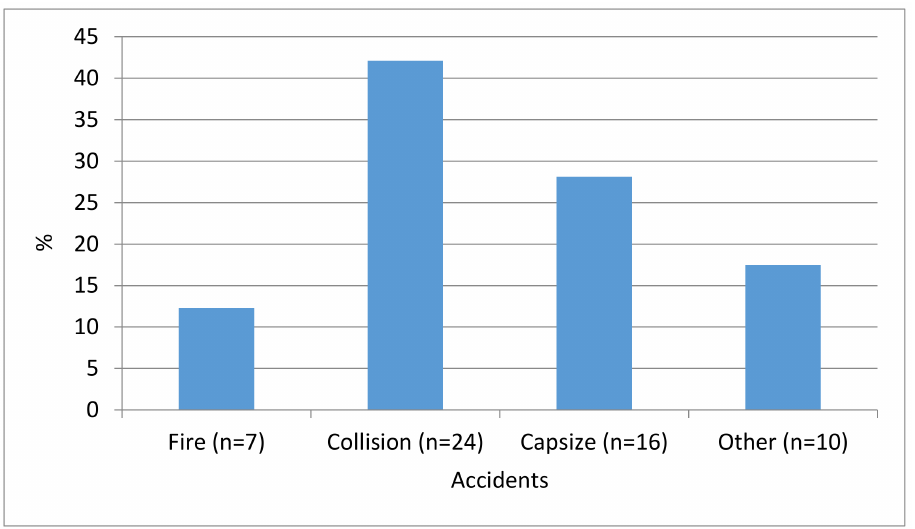
Figure 3. Reasons for shipwreck in the period 1998–2016.